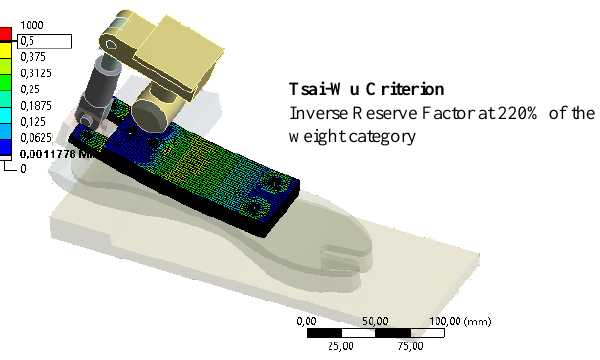
Figure 26. Upper blade and middle blade evaluated with the Tsai–Wu criterion; the most critical areas, when the foot was loaded with the 220% of body weight of intended users, presented an inverse reserve factor of 0.5, which means a safety factor of 2.